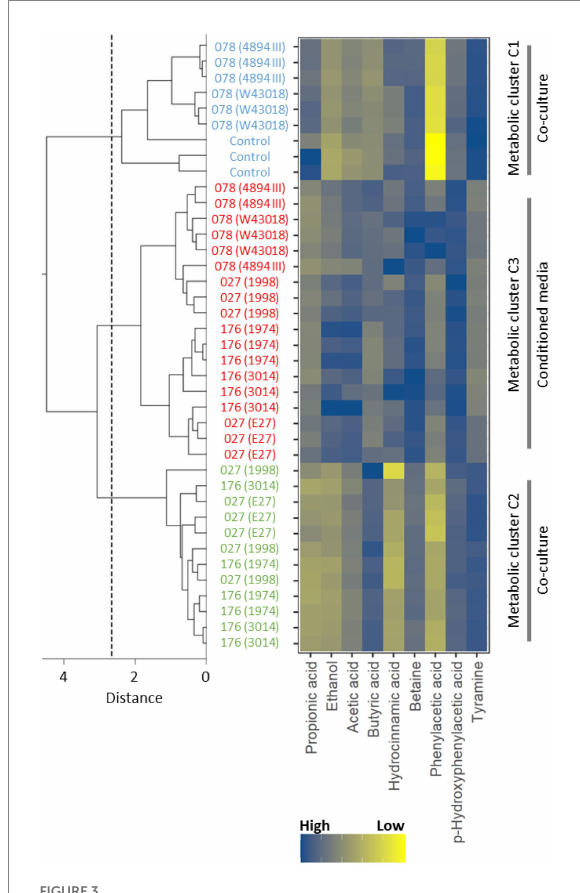
FIGURE 3 A dendrogram of the hierarchical cluster tree of NMR spectra of supernatants with respect to concentration differences of nine metabolites identified by the general explanation method. The blue color indicates the control supernatant samples of children fecal microbiota only and samples of co-cultures children fecal microbiota/ C. difficile ribotype 078 strains (W43018, 4894; cluster 1), the green color marks the supernatant samples of co-cultures children fecal microbiota/ C. difficile ribotypes 027 and 176 strains (E27, 1998, 3014, 1974; cluster 2) and the red color represents the supernatant samples of children fecal microbiota in C. difficile conditioned media (all ribotypes; cluster 3). The dashed line indicates the distance, at which the supernatant samples divide into three